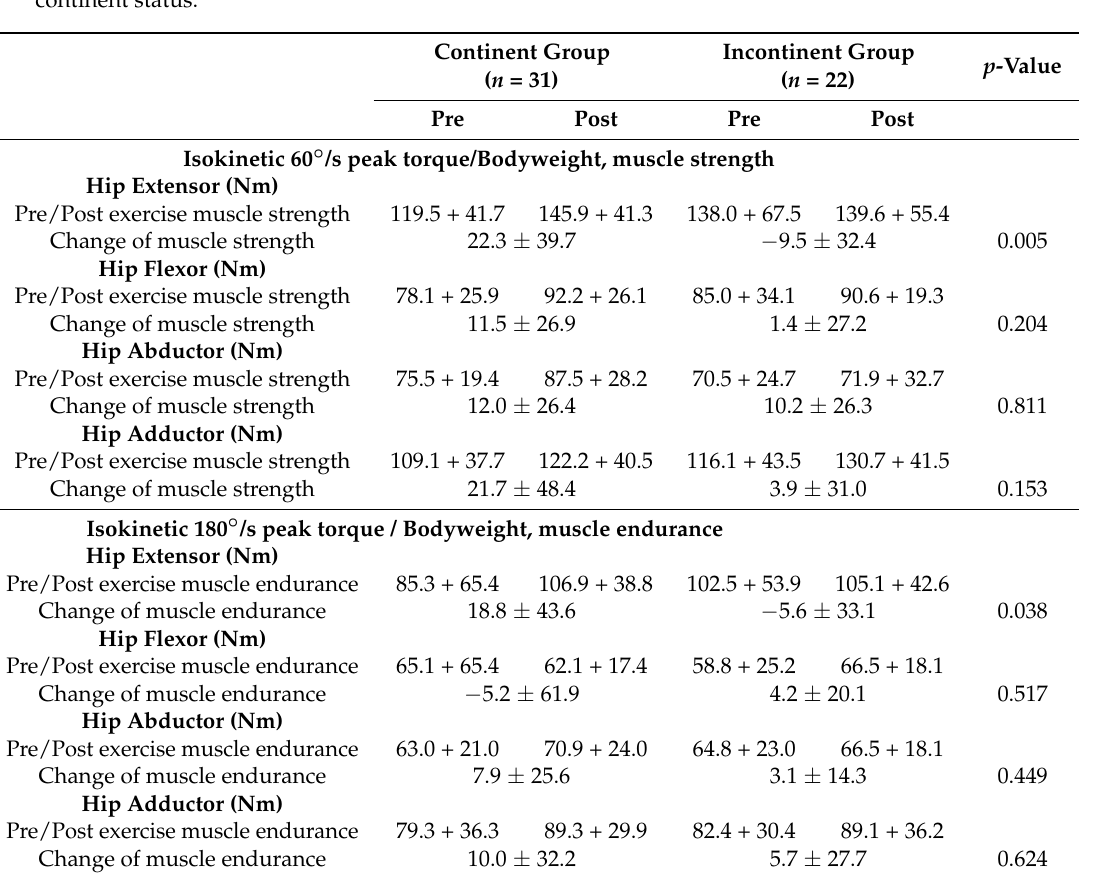
Table 2. Change of pelvic muscle strength and endurance according to the achievement of post-exercise continent status.